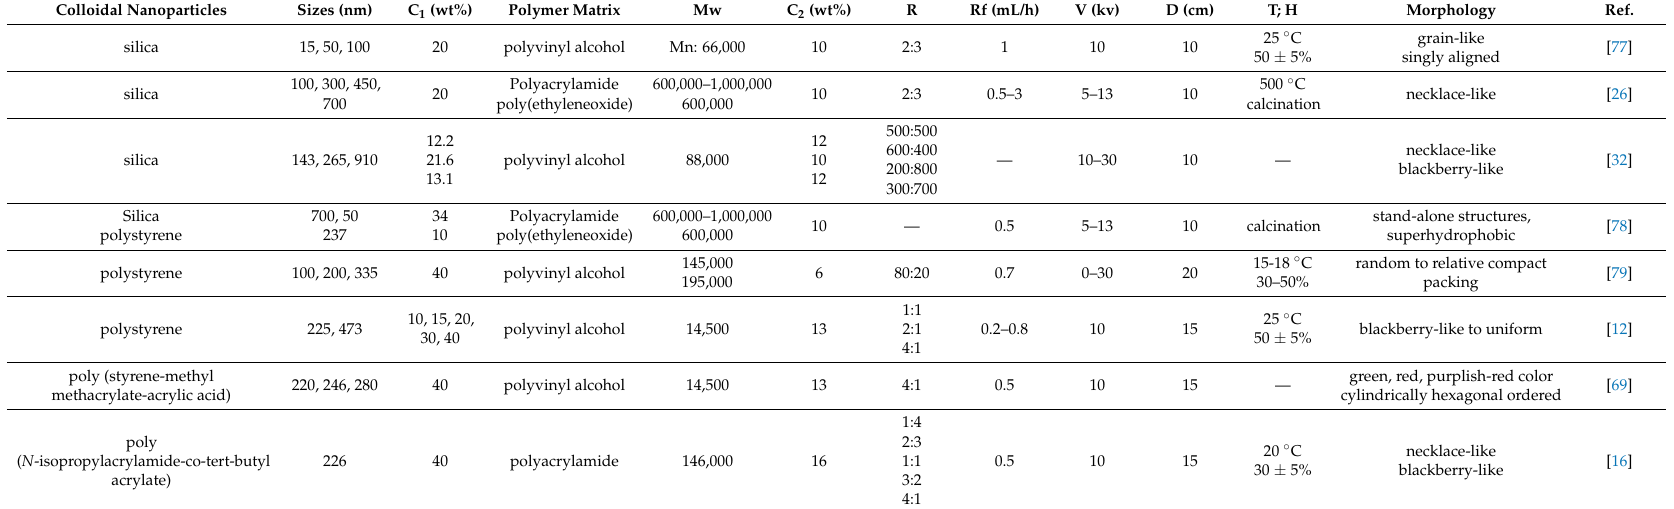
Table 1. Fundamental parameters of nanoparticles contained electrospun nanofibers with well-aligned morphology. Colloidal